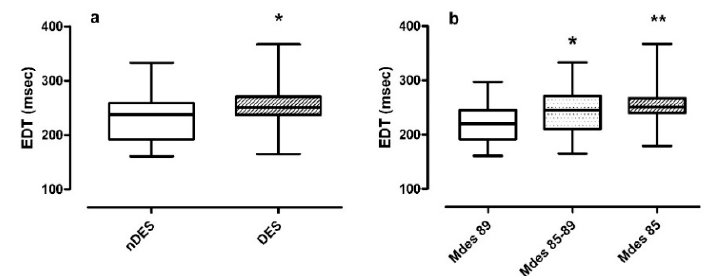
Figure 3. EDT values boxplot stratified for T90 classification (DES / nDES) ( a ) and for Mdes severity (mild / moderate / severe) ( b ). Legend: EDT = trans-tricuspid E-wave deceleration time; DES = oxygen desaturators; nDES = non oxygen desaturators; Mdes = mean desaturation peak values of nocturnal events; Mdes 89 = Mdes ≥ 89% = mild group; Mdes 85–89 = Mdes < 89% and > 85% = moderate group; Mdes 85 = Mdes ≤ 85% = severe group; DES vs. nDES: * p < 0.05; Mdes 85–89 vs. Mdes 89; * p < 0.05 and Mdes 85 vs. Mdes 89: ** p < 0.01.